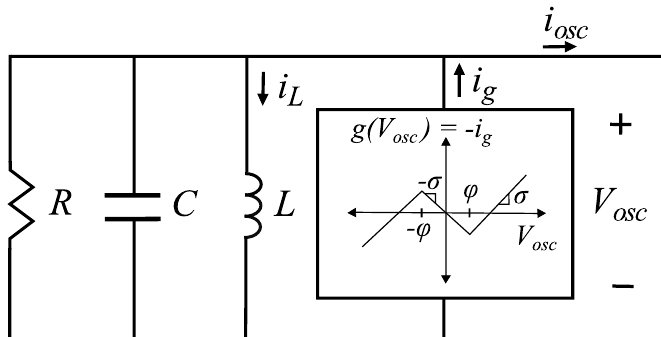
Figure 5. Circuit model of the Dead-Zone Oscillator. i g , the output of the voltage-dependent current source, is a nonlinear function g ( V osc ) . The impedance of the parallel resistor inductor capacitor (RLC) circuit, together with the parameters σ and ϕ of g ( V osc ) , control the limit cycle of a single oscillator and the interaction of coupled DZOs